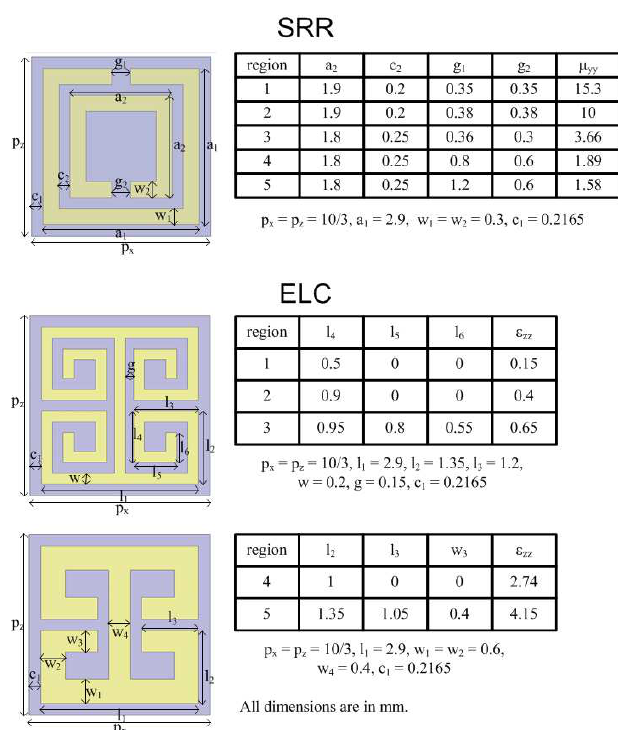
Figure 3: Unit cell of the SRR used as magnetic material and of the ELC used as electric material. The tables summarize the dimensions of these two metamaterial cells to achieve the different values of the electromagnetic parameters needed for the transformation.